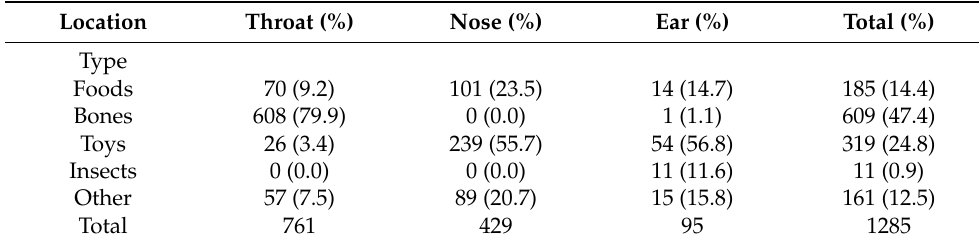
Table 3. Types of foreign bodies on the basis of location.